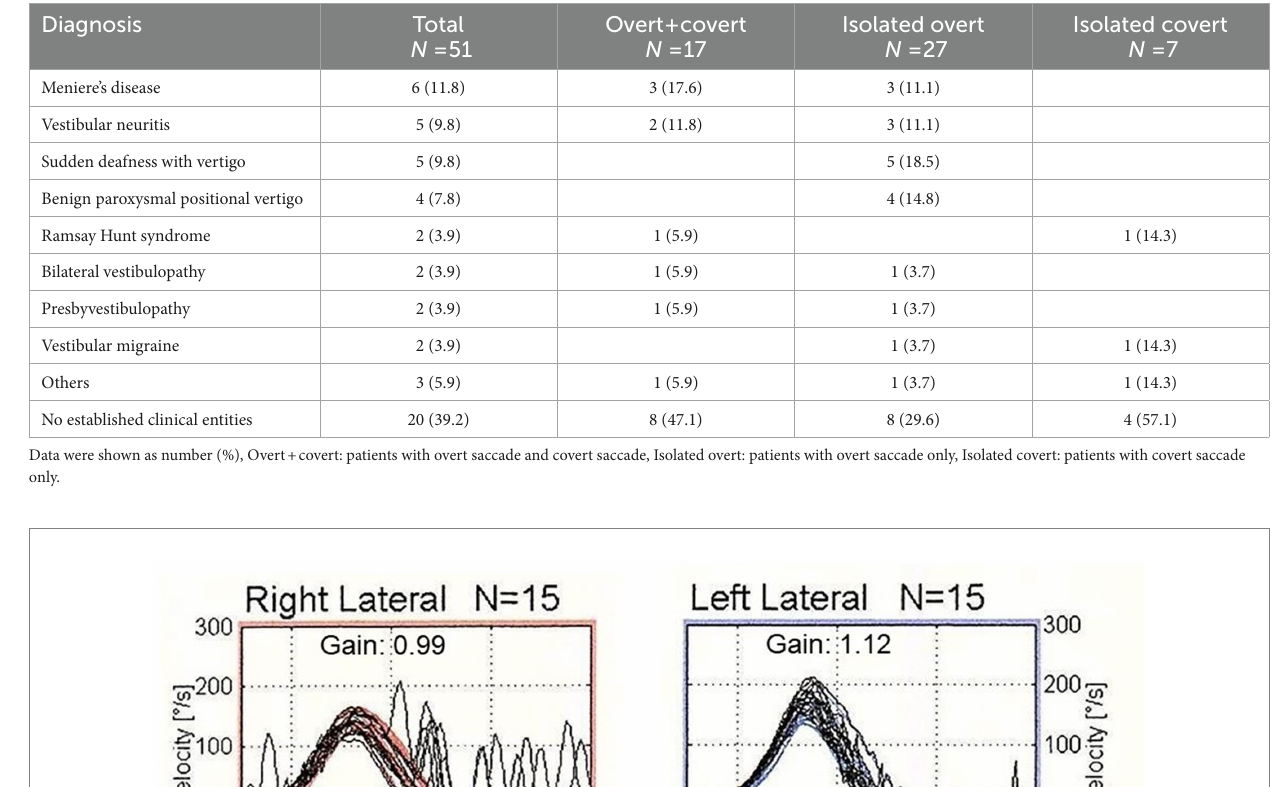
TABLE 1 Clinical diagnosis of 51 patients who showed corrective saccades (CS) with normal vestibulo-ocular reflex (VOR) gain in video head impulse test (vHIT).